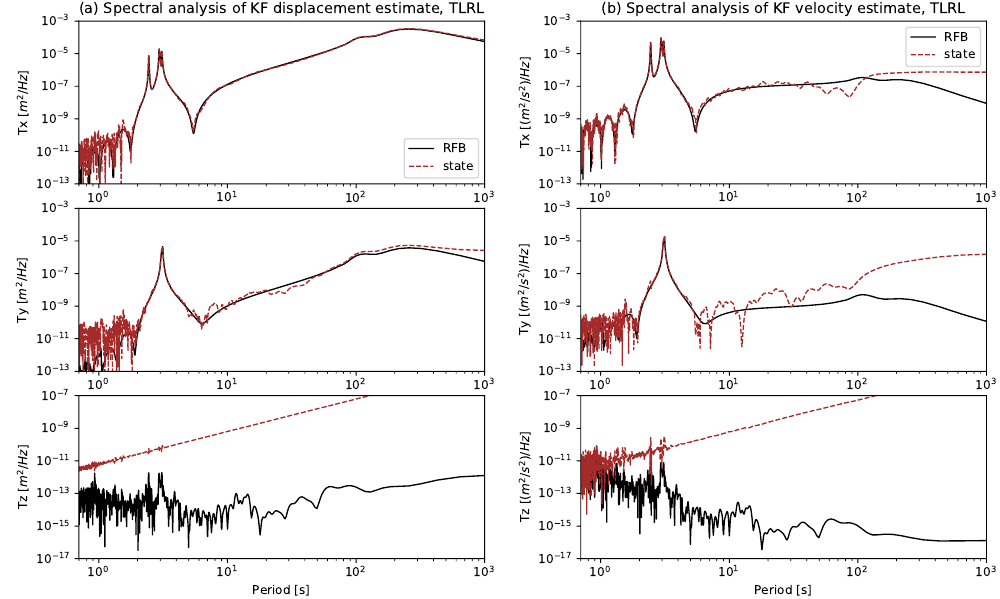
Figure 6. The robot feedback (RFB) is plotted in black and the KF estimate (state) is plotted in brown for the TLRL experiment. The ( a ) shows the KF displacement estimate and ( b ) shows the KF velocity